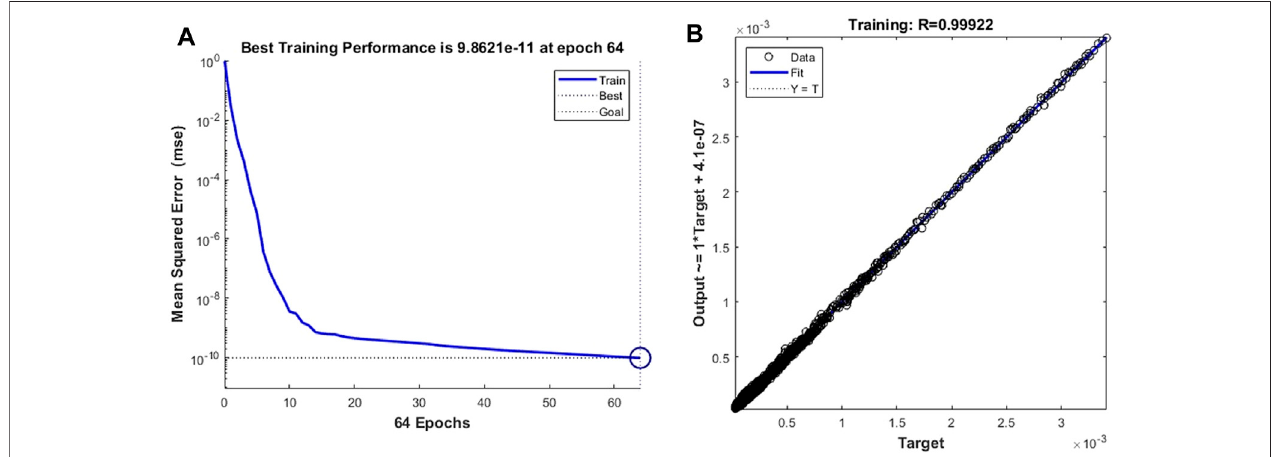
FIGURE 10 | The training performance and fi tting curve of the leukocyte transmigration prediction model used for cell down fl ow velocity prediction (A) Training performance; (B) Fitting curve.